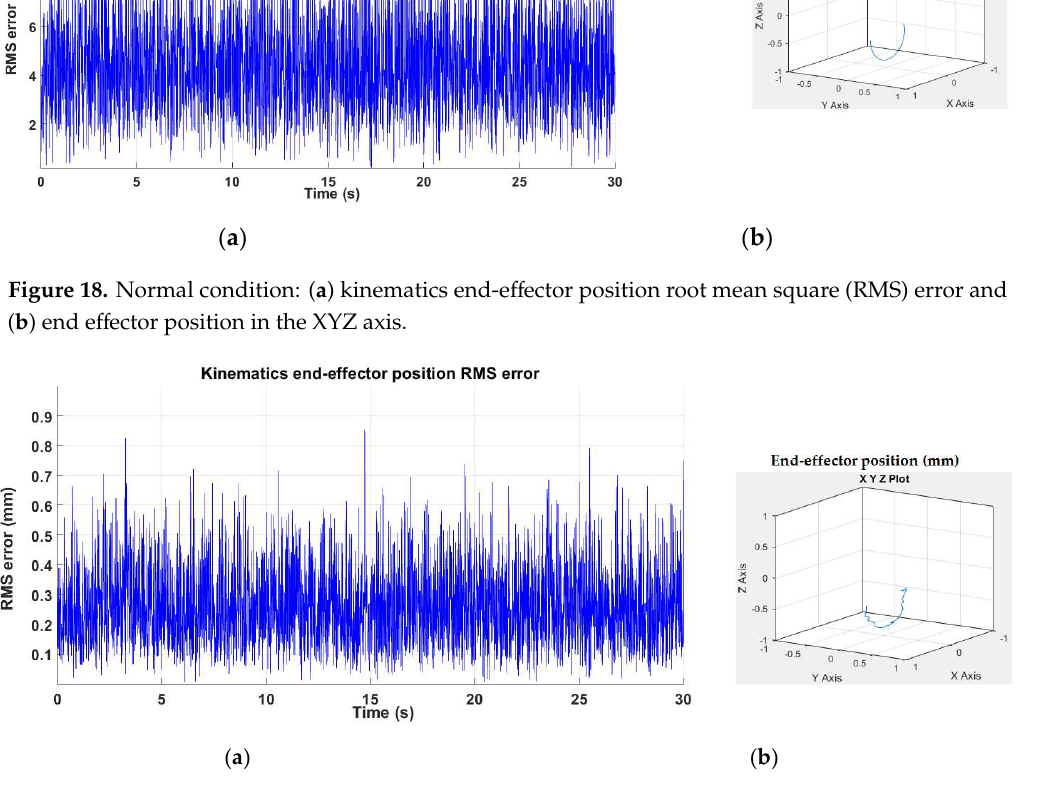
Figure 19. Actuator fault condition: ( a ) kinematics end-effector position RMS error and ( b ) end effector position in the XYZ plot.